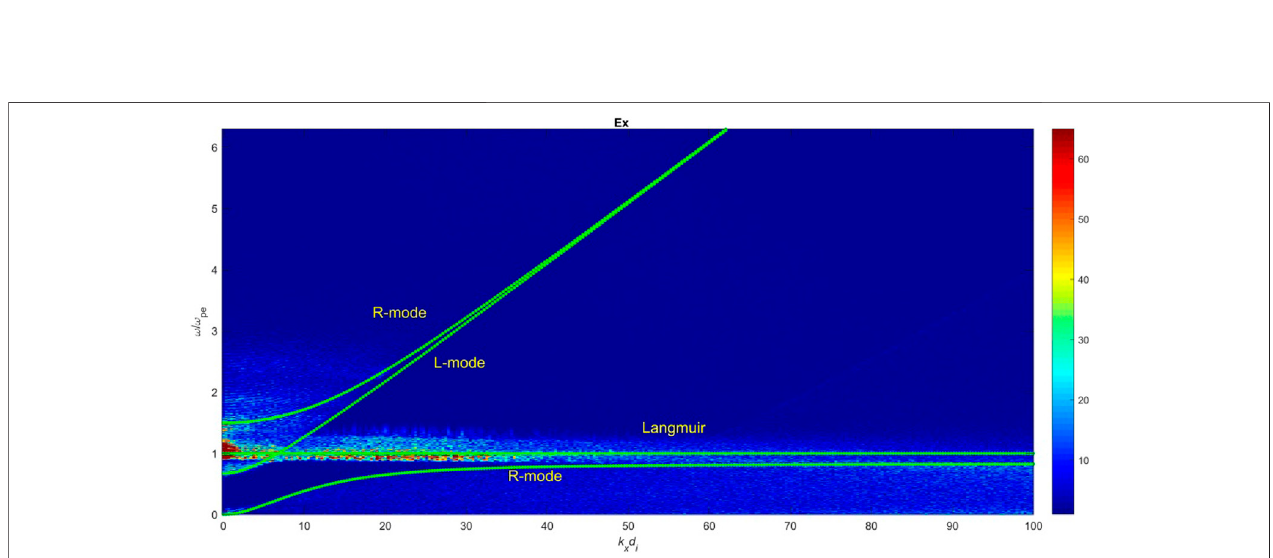
FIGURE 5 | Dispersion diagram of Ex ( x / d i (0: 18.5), y / d i (cid:1) 13). Dotted lines indicate the theoretical parallel propagating modes along the initial magnetic fi eld.